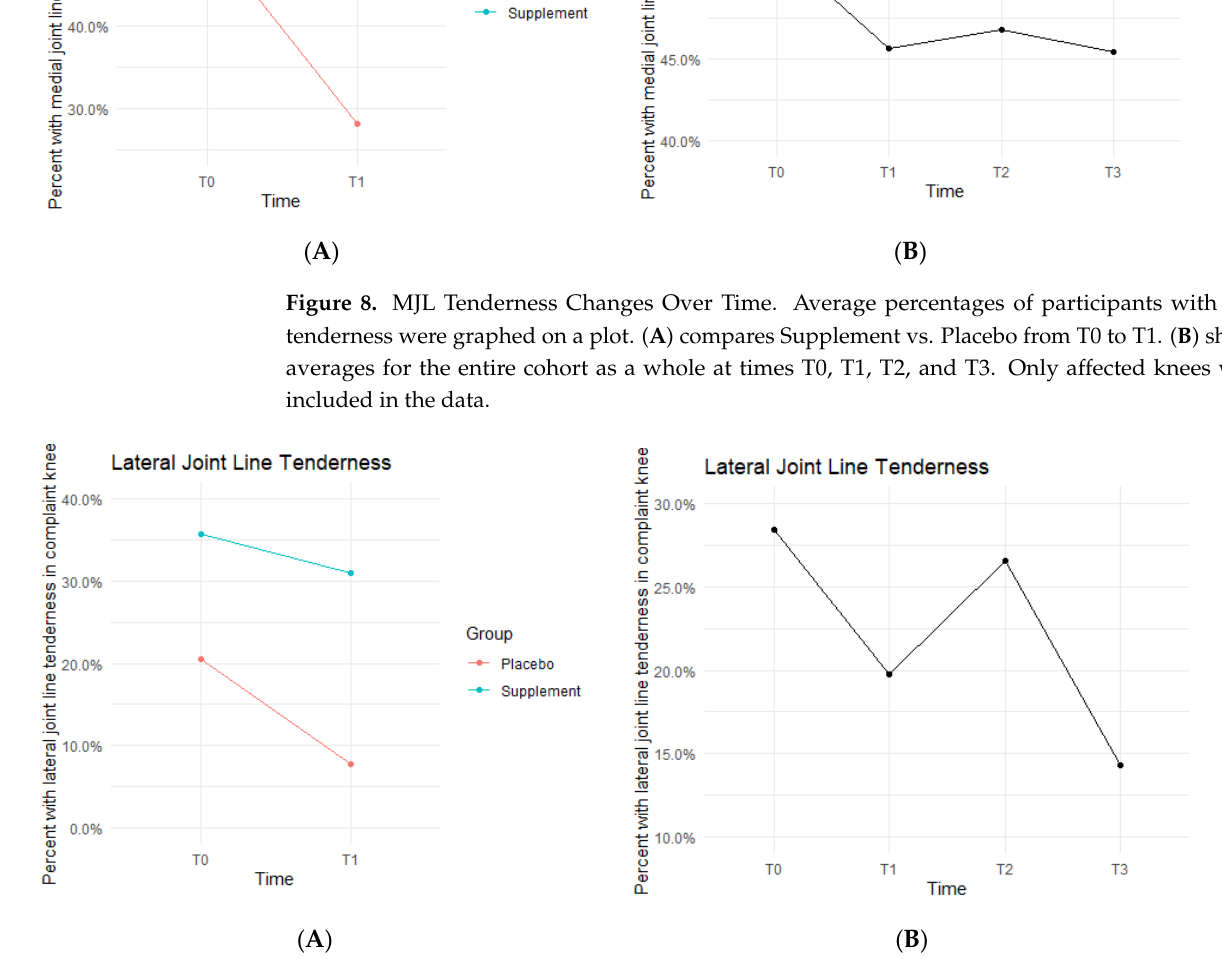
Figure 8. MJL Tenderness Changes Over Time. Average percentages of participants with MJL ten ‐ derness were graphed on a plot. ( A ) compares Supplement vs. Placebo from T0 to T1. ( B ) shows averages for the entire cohort as a whole at times T0, T1, T2, and T3. Only affected knees were in ‐ cluded in the data.